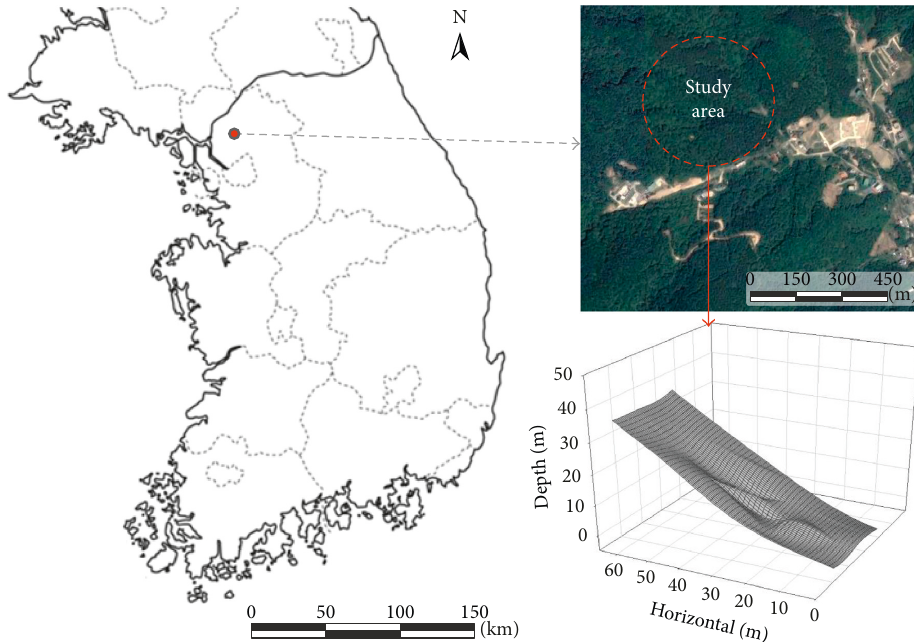
Figure 4: Location of the study area and surface plot.